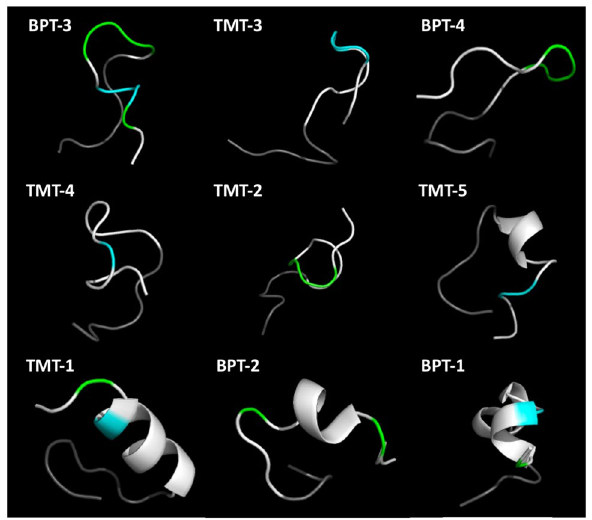
Figure 3. Secondary structure of trans-TM peptides, in order of decreasing transport rate from top left to bottom right. Coiled-coil structure is clearly associated with the lowest transport rates. The structures are oriented with the terminal six amino acids of the M13 phage pIII protein, colored gray, on the lower left. The amino acids of Motif 1 are indicated in blue, while those of Motif 2 are indicated in green.